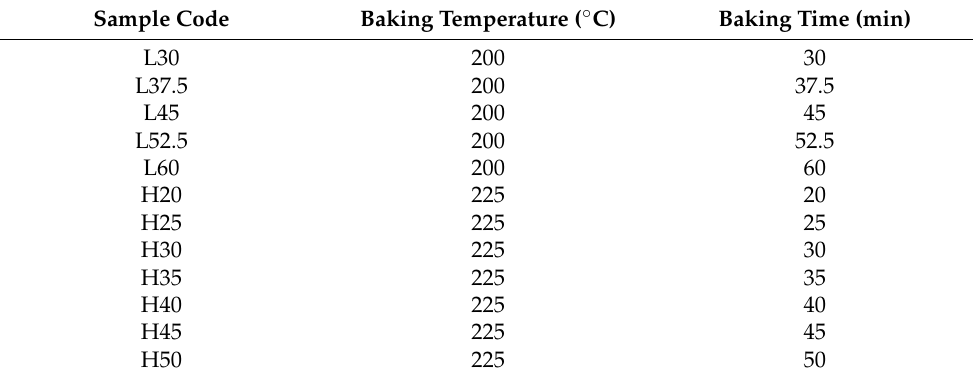
Table 1. Bread samples identification and baking